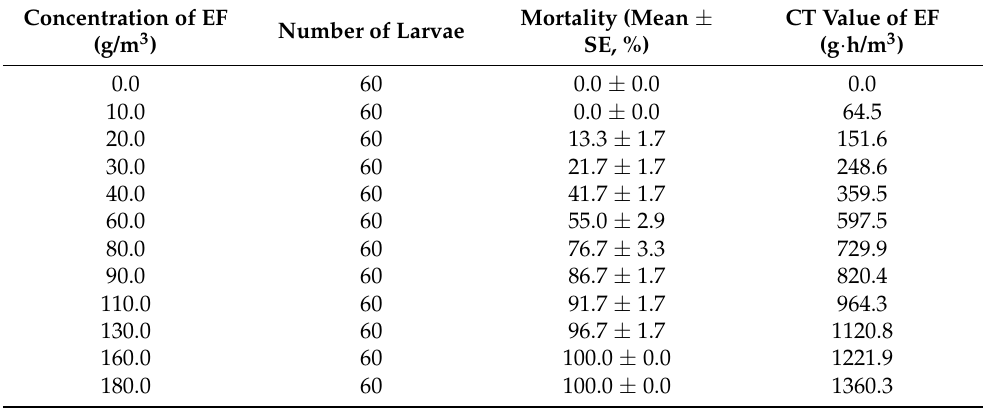
Table 1. Mortality of Curculio sikkimensis and CT values after 12 h of fumigation at 15 ◦ C (filling ratio = 2.5%). Concentration of EF